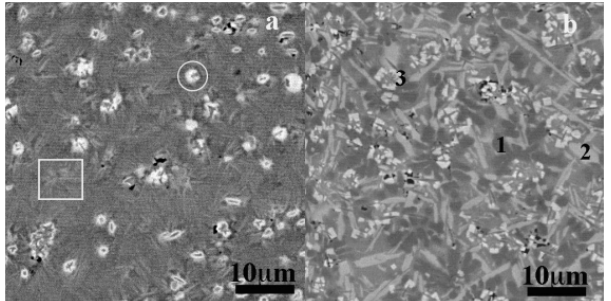
Figure 6. SEM-BEI micrographs of 8 mm diameter Fe by injection casting. ( a ) Fine acicular structure of the skin area; ( b ) Coarse acicular structure in the central